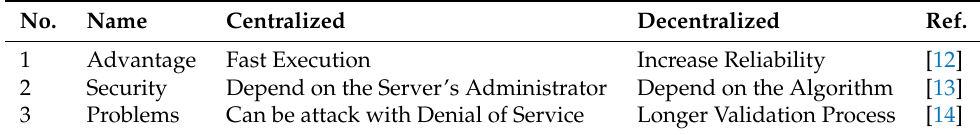
Figure 2. Centralized and decentralized network architecture. Table 1. Comparison of centralized vs.